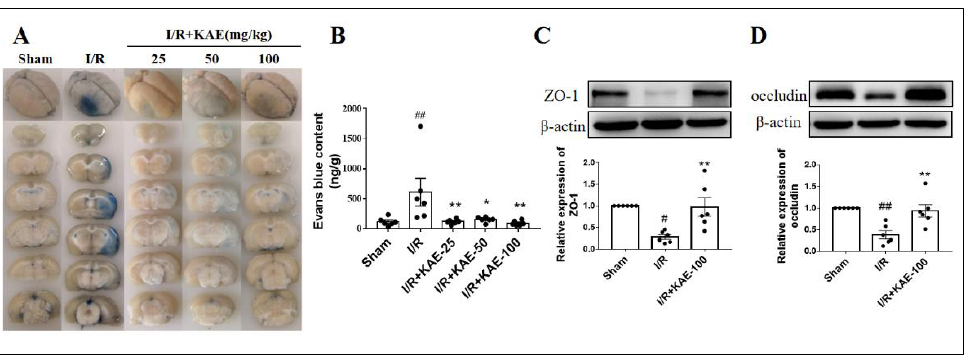
Figure 5. Effect of kaempferol on BBB disruption of rats on day 3 after cerebral I/R. ( A ) Representative images of Evans blue staining. ( B ) Quantitative analysis of Evans blue content in ischemic hemisphere. The expression levels of ( C ) ZO-1 and ( D ) occludin were assessed by Western blot analysis. Values are expressed as mean ± SEM ( n = 6). # p < 0.05, ## p < 0.01 vs. Sham group; * p < 0.05, ** p < 0.01 vs. I/R group. KAE: kaempferol.